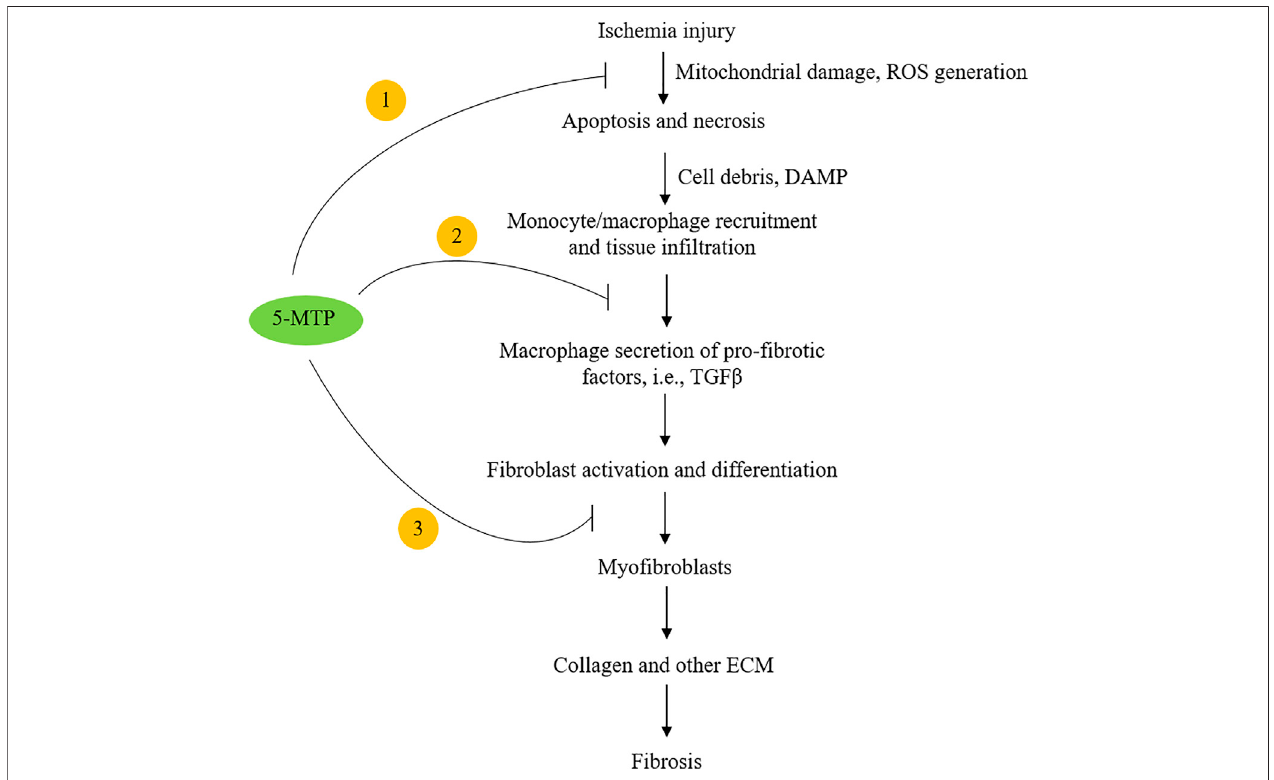
FIGURE 2 | Highlight of the potential mechanisms by which 5-MTP inhibits cardiac fi brosis. 5-MTP exerts cellular actions by ① scavenging ROS and reducing apoptosis; ② blocking macrophage secretion of TGF β and other pro- fi brotic factors and ③ reducing myo fi broblasts.